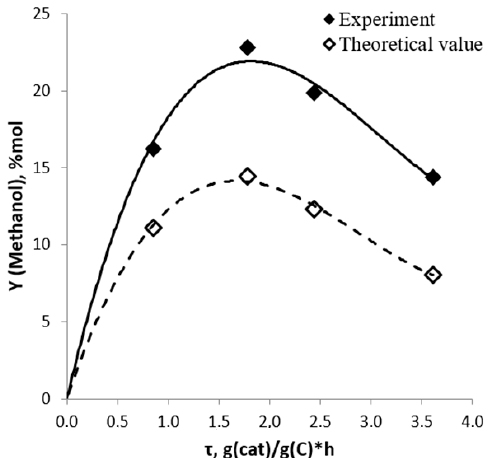
Figure 7. Yield of methanol (Y, mol %) as a function of specific contact time ( τ , g(cat)/g(C)*h) for Mg-